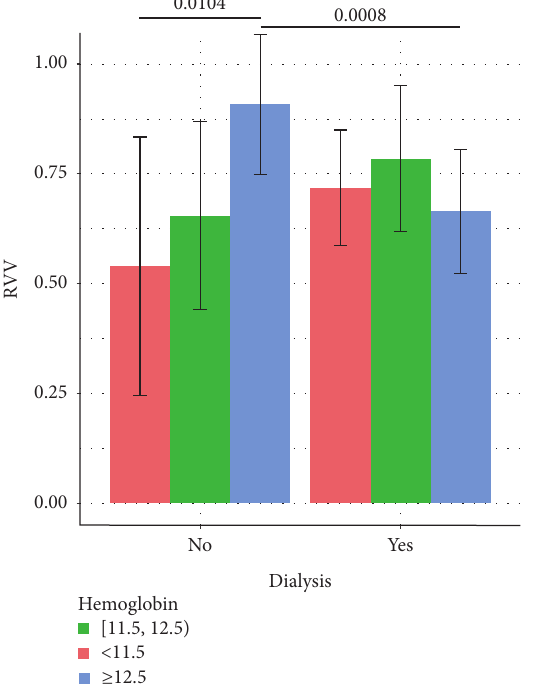
Figure 1: Effect of hemoglobin and dialysis on the right carotid adventitial VV. Hemoglobin at levels of 12.5g/dL or above deter- mines higher levels of the right carotid adventitial VV (RVV). Bars and error bars represent the mean and the 95% CI of the